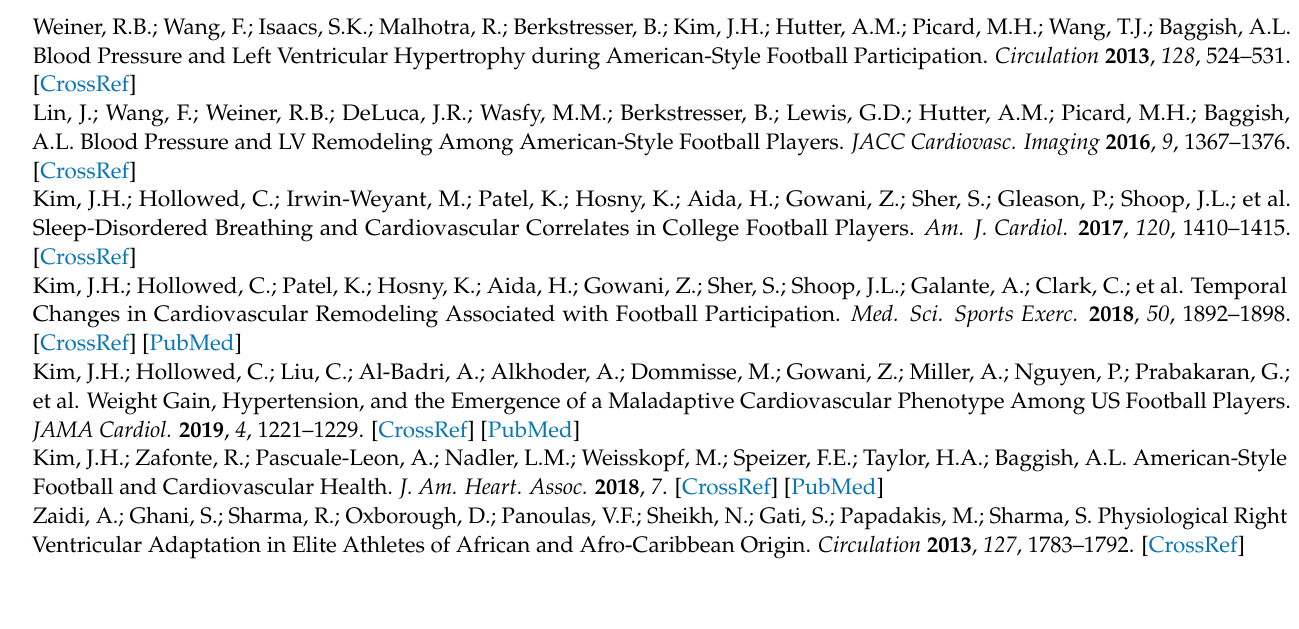
program, statistical analysis. Supplementary Tables: Table S1: Mixed-effect model results for assessing differences in right ventricular and atrial remodeling due to the field position, Table S2: Univariate and multivariate analysis for prediction of intra-seasonal right ventricular dilatation in the entire cohort, Table S3: Comparison of pre-training (pre-T) and post-training (post-T) left ventricular and atrial parameters, Table S4: Mixed-effect model results for assessing differences in left ventricular and atrial remodeling due to the field